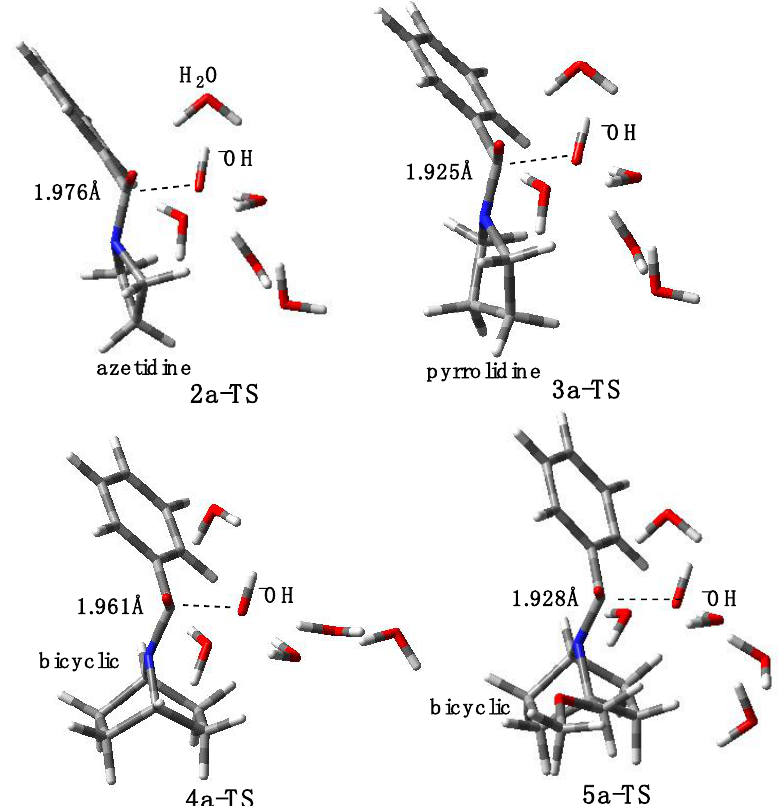
Figure 12. M06-2X/6-31+G(d)-optimized transition structures of hydroxide anion addition to the amide. Distance between the amide carbonyl carbon atom and hydroxide oxygen atom was shown.